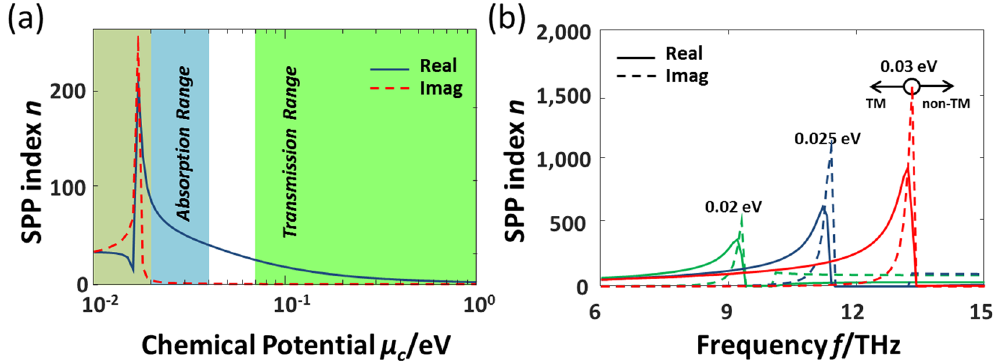
Figure 3. ( a ) SPP index as a function of chemical potential. The curves are calculated at f = 8 THz, τ = 0.3 ps and T = 300 K. ( b ) SPP index as a function of frequency at μ c = 0.02, 0.025 and 0.03 eV, τ = 0.3 ps and T = 300